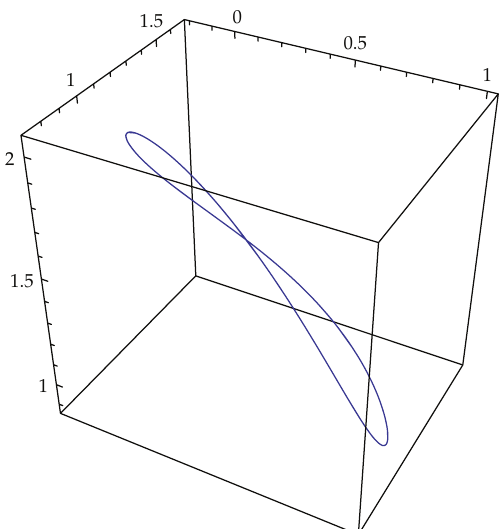
Figure 2: The 4th-step Runge-Kutta integrator of the system (cid:7) 3.8 (cid:8) (cid:7) c 1 (cid:6) 1, c 2 (cid:6) 2, c 3 (cid:6) 3, k (cid:6) 10, and x 1 (cid:7) 0 (cid:8) (cid:6) x 2 (cid:7) 0 (cid:8) (cid:6) x 3 (cid:7) 0 (cid:8) (cid:6) 1 (cid:8)